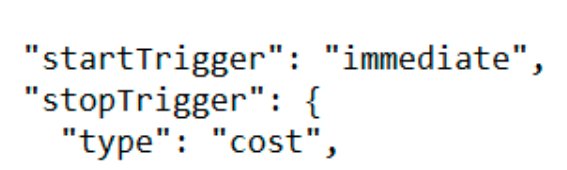
Figure 28. Charging request message.